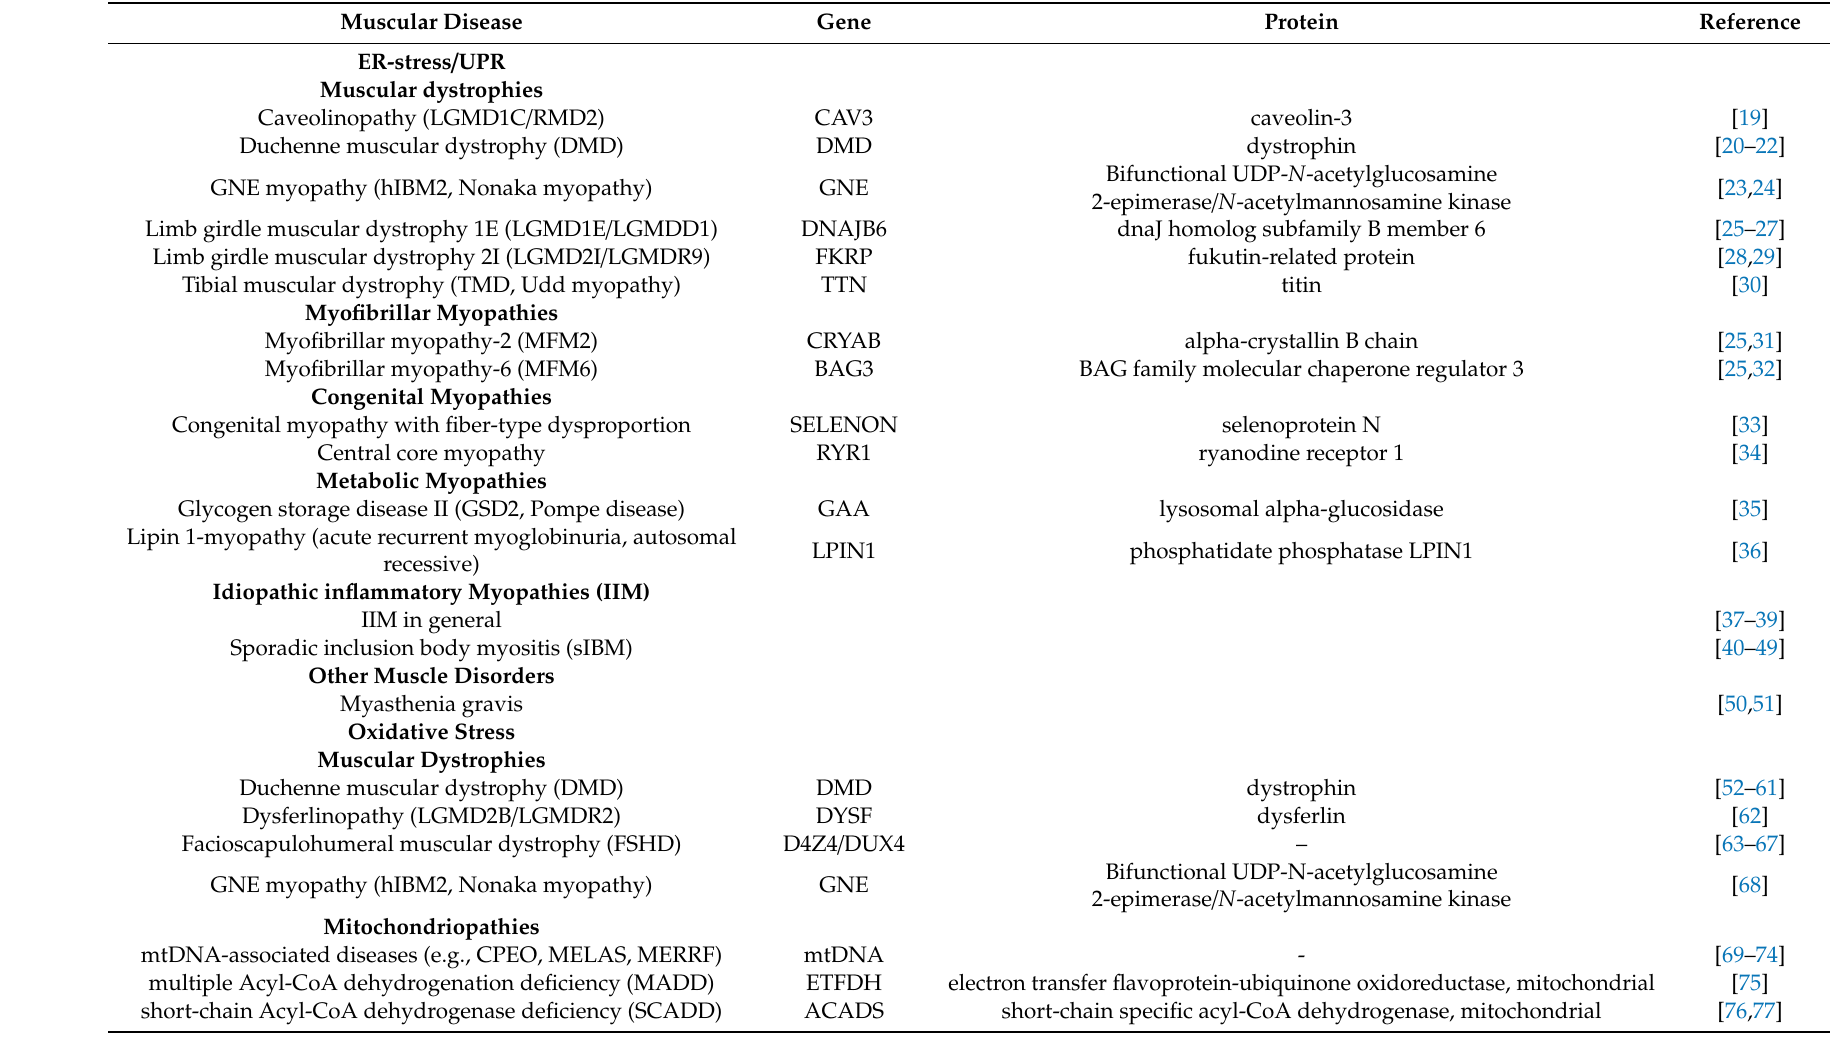
Table 1. Muscular diseases with deregulated cellular stress